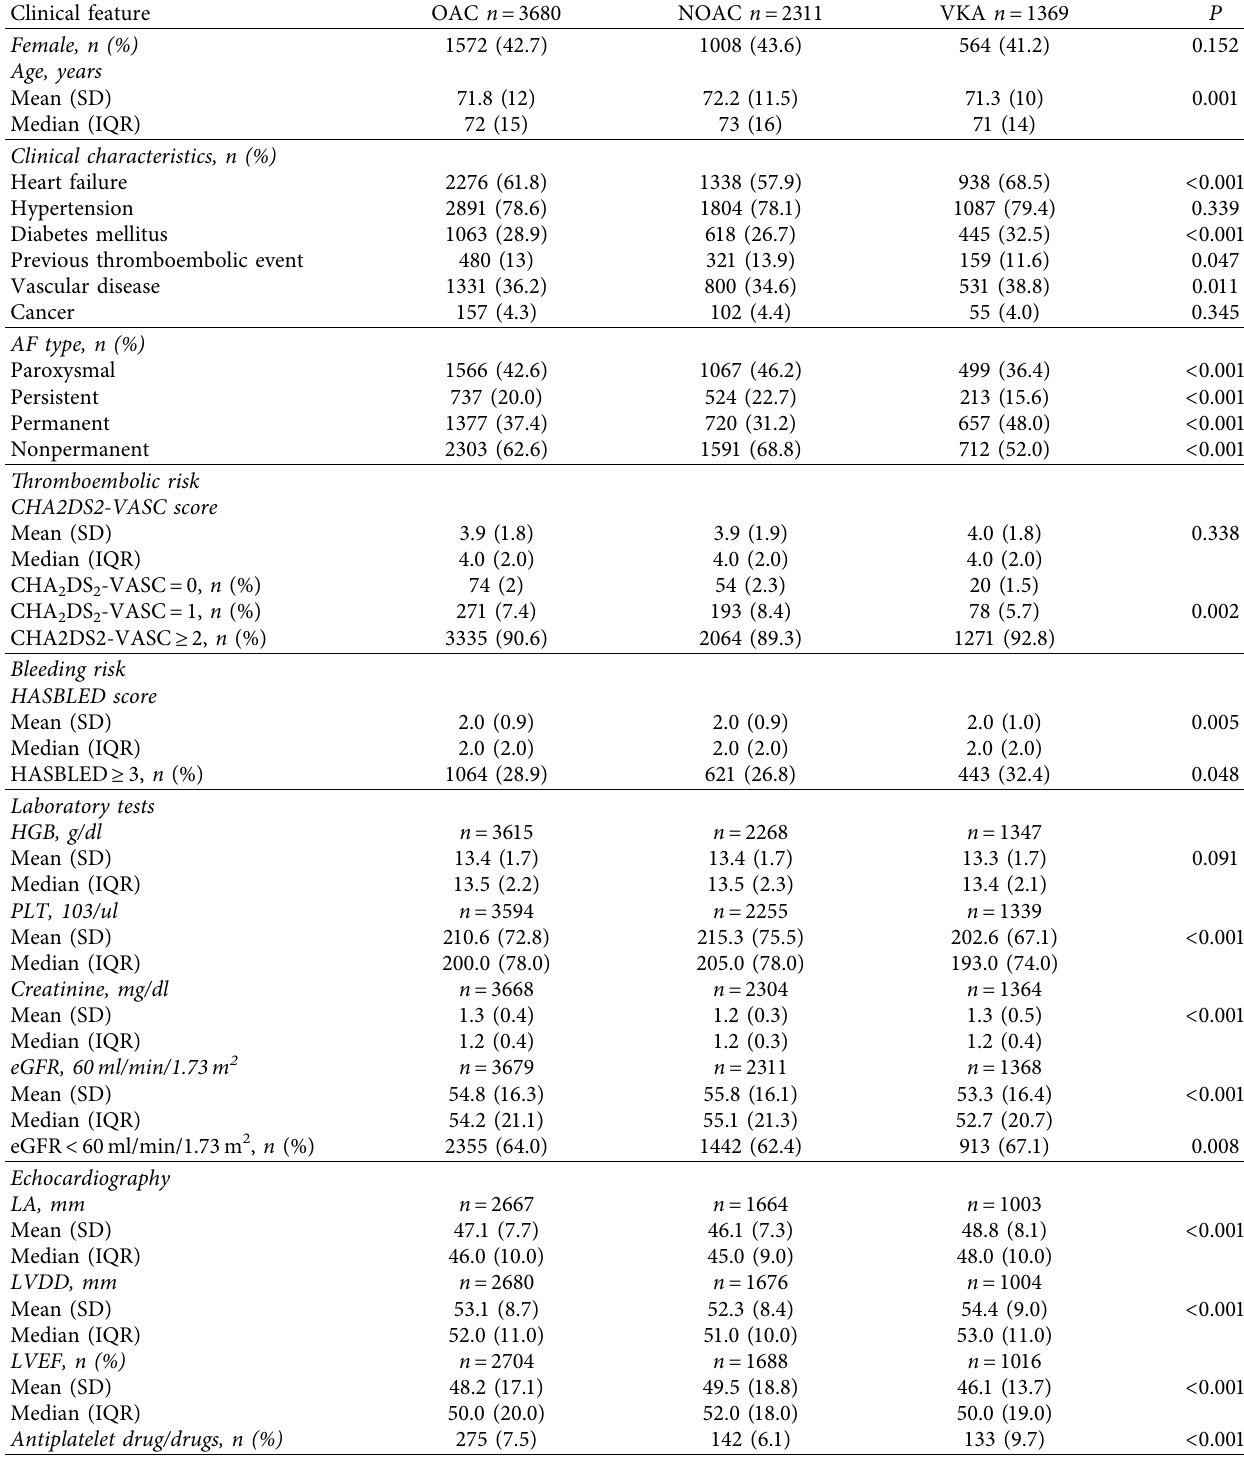
Table 2: Clinical characteristics of patients with atrial fibrillation treated with vitamin K antagonist and non-vitamin K antagonist oral